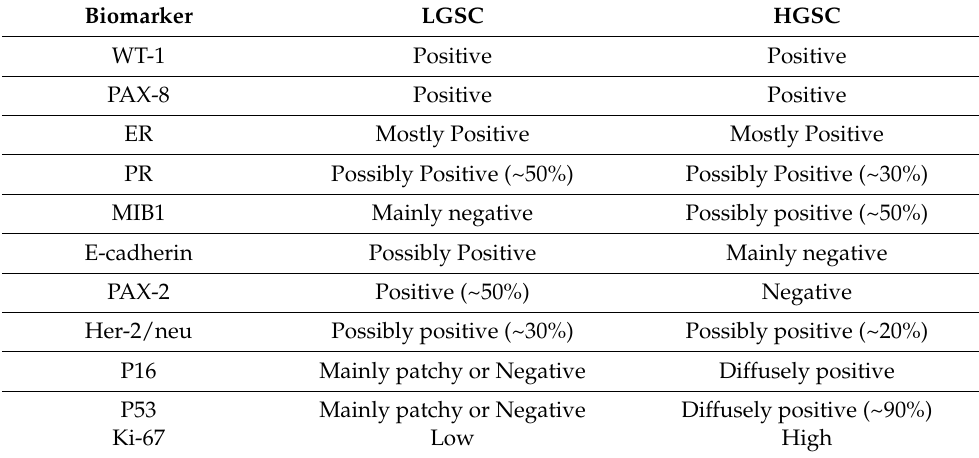
Table 3. Typical IHC profile of LGSC compared to